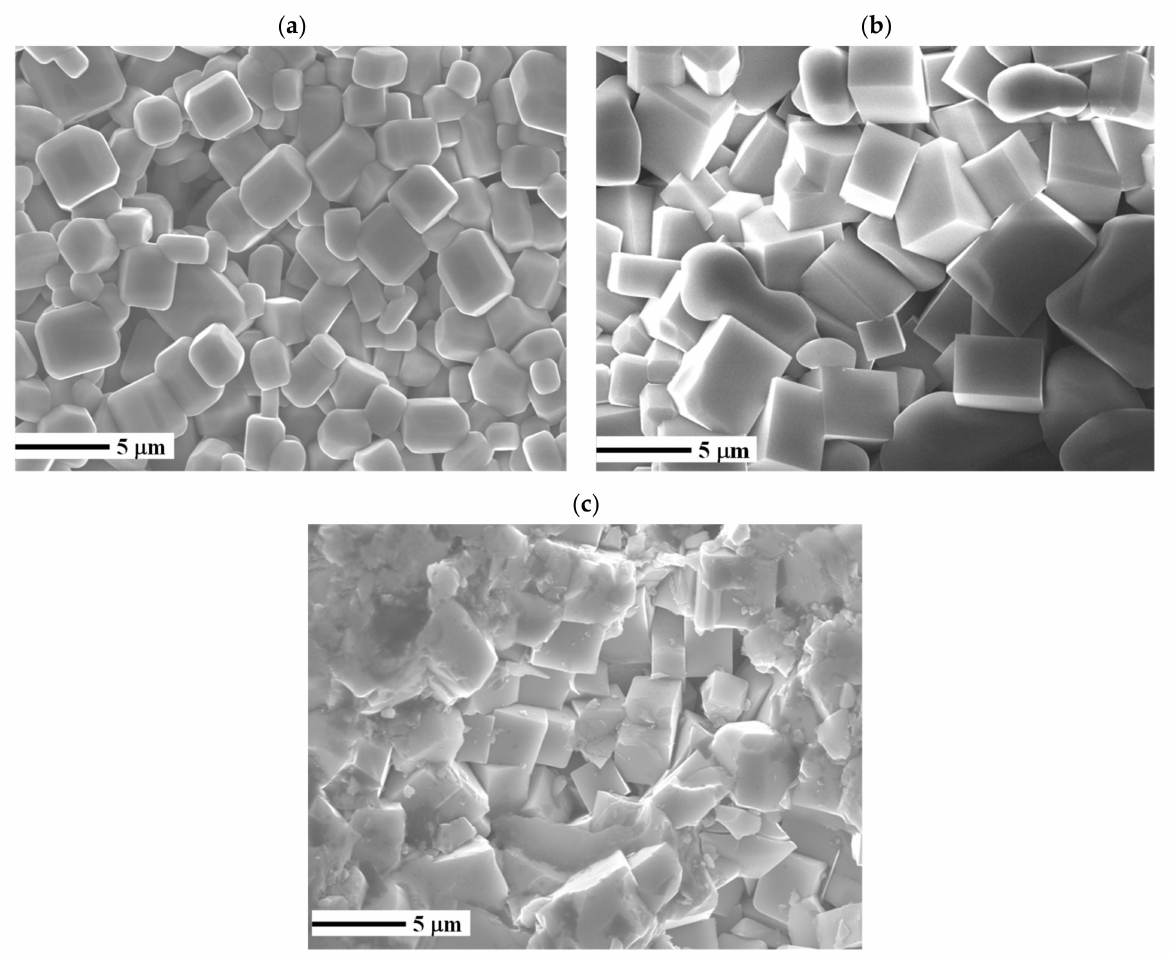
Figure 2. FE-SEM morphology of BCTO ceramics ( a ) BCTO-950, ( b ) BCTO-975, and ( c ) BCTO-990. Figure 3 shows the EDS spectra for the BCTO ceramics. The presence of Bi, Cu, Ti, and O in the ceramics was confirmed and their atomic percentage is given in Table 1. As seen from the table, the ratio between elements corresponds to the nominal values for BCTO composition. Moreover, the oxygen content in the ceramic samples BCTO-950 and BCTO-975 is higher than in the ceramic BCTO-990.